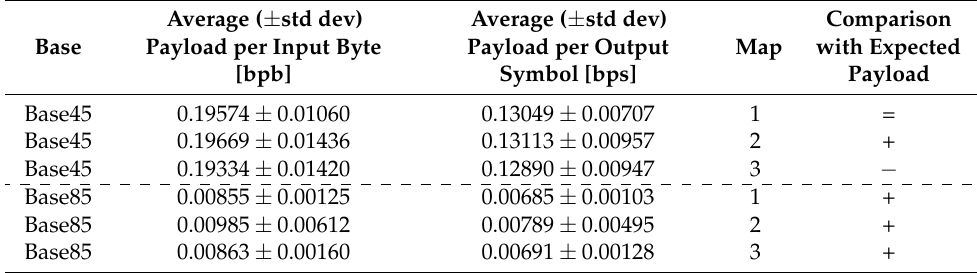
Table 8. Results of the Base45 and Base85 encodings applied to 112 compressed files (formats: .zip, .bz2,